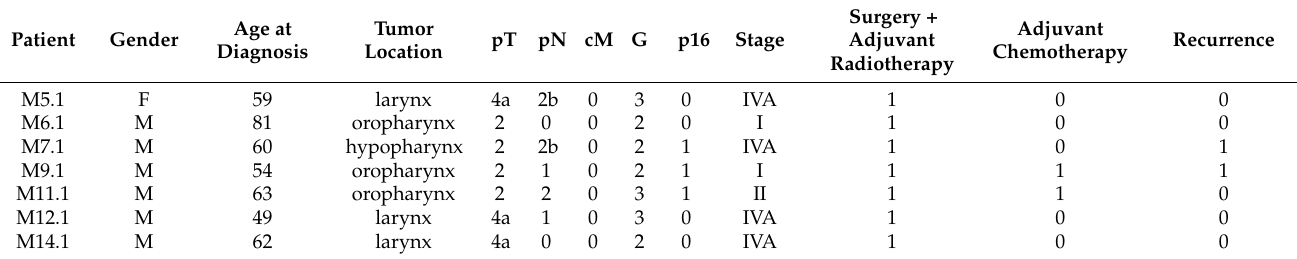
Table 1. Clinico-pathological characterization of head and neck squamous cell carcinomas (HNSCC) patients based on TNM staging and grading (8th